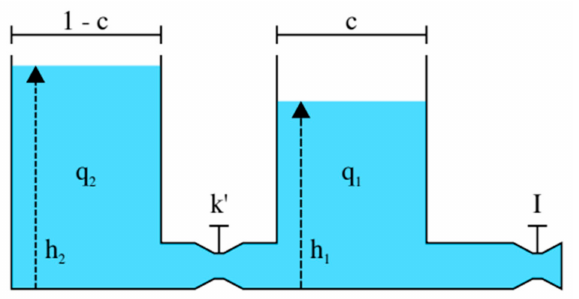
Figure 2. Kinetic Battery